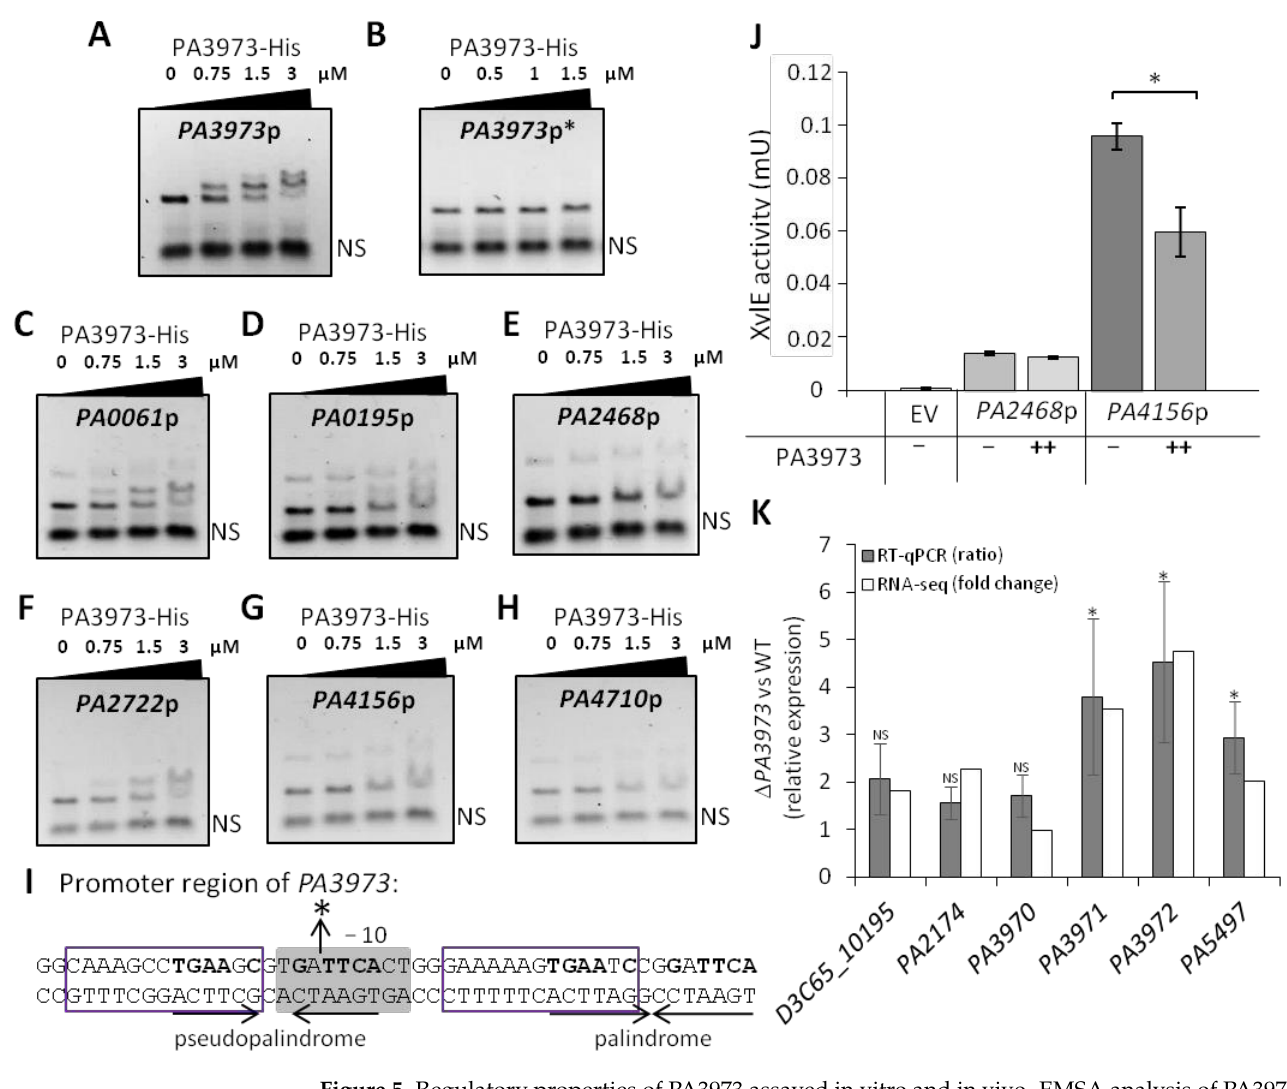
Figure 5. Regulatory properties of PA3973 assayed in vitro and in vivo. EMSA analysis of PA3973- His 6 binding to regions preceding PA3973 [long ( A ) and short promoter fragment ( B )], PA0061 ( C ), PA0195 ( D ), PA2468 ( E ), PA2722 ( F ), PA4156 ( G ), PA4710 ( H ). Amplified DNA fragments were incubated with the indicated amounts of the protein in the presence of unspecific, competitor DNA (marked as NS), and complexes were separated by electrophoresis on 1.5% agarose gel. Ethidium bromide staining was used for the visualization of DNA. ( I ) Sequence preceding the PA3973 gene. Probable binding motifs are marked with the purple box. “*” indicates the site of truncation of PA3973 p to obtain its shorter fragment. ( J ) XylE activity in E. coli DH5α carrying pMEB267 ( PA2468 p- xylE ) or pMEB269 ( PA4156 p- xylE ) with pKKB3.11 ( tac p- PA3973 ) (++) or empty plasmid pAMB9.37 ( − ). Strains were grown in selective LB with supplementation of 0.2 mM IPTG for pKKB3.11 (++). Cells carrying the promoter-less pPTOI (- xylE ) (EV) and pAMB9.37 were used as background control. The data represent the means ± SD and * indicates p < 0.05 in a Student’s two - tailed t-test. ( K ) The genes with altered expression in Δ PA3973 strain vs. WT PAO1161 as indicated by RNA-seq analysis and RT-qPCR analysis carried out using RNA samples obtained for the same conditions as samples used for RNA-seq analysis. The results of RNA-seq data are presented as a fold change according to data presented in Table S6, while RT-qPCR data are presented as a ratio. Data represent mean ratio ± SD for three biological replicates. * indicate significantly different ex- pression (ratio > 2, p -value < 0.05 in two-sided Student ’ s t-test assuming equal variance) comparing Δ PA3973 with WT using the proC reference gene; NS — not significant.